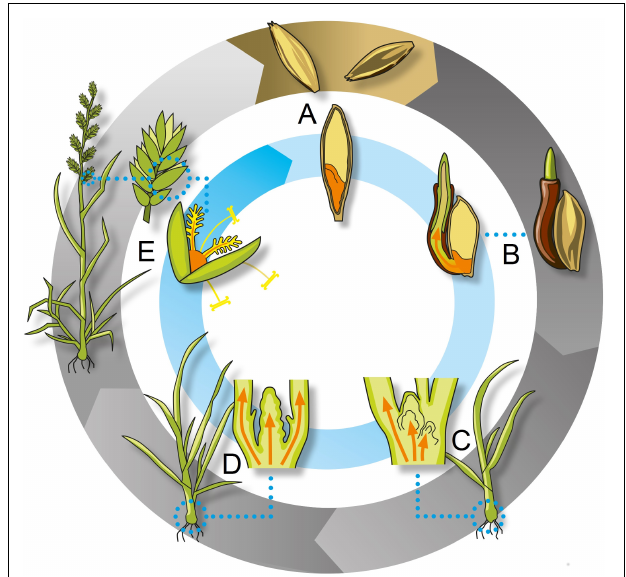
FIGURE 1 | Vertical transmission of Epichloë festucae var. lolii hyphae. The outer ring represents the grass reproductive cycle (both vegetative and sexual), and the inner ring the fungal vertical transmission cycle (asexual only). Within mature seeds (A) , hyphae (orange) are present in the embryo, as well as a number of other seed structures such as the scutellum, and a region between the embryo and the endosperm called the “infection layer” (Philipson and Christey, 1986; Card et al., 2011). Upon germination (B) , hyphae within the embryo colonize the seedling, including the shoot apical meristem, and developing shoot organ primordia using hyphal tip growth that allows the branching of hyphae required to colonize and ramify through meristem and organ primordia. By contrast, hyphal extension in growing leaves occurs primarily through intercalary compartment growth until the leaf matures (Christensen et al., 2008). Each leaf subtends an axillary bud which is colonized prior to tiller outgrowth, thus enabling the hyphae to colonize the shoot apex of the newly formed daughter tillers (C) and from there, all nascent aerial plant structures. The resulting grass plants are comprised of a hierarchy of tillers and it is not uncommon for all tillers of an infected grass plant to contain hyphae. However, organ primordia that have escaped hyphal colonization are generally observed to develop endophyte free (Wilson and Easton, 1997; Christensen et al., 2000). Under environmental cues (temperature, light duration), each vegetative shoot apex has the potential to differentiate into a reproductive inflorescence primordium (D) . Hyphae colonize the developing reproductive tissues, and can be identified among the cells of most floral tissues, including the ovaries (E) . Upon fertilization, hyphae in the ovary penetrate the embryo and are incorporated into other seed structures (Sampson, 1933; Liu et al., 2017; Zhang et al., 2017). It is noted that hyphae have not been observed in grass pollen (Liu et al., 2017) and thus the transmission of endophytes into seed through the asexual cycle is generally deemed to be exclusively maternal. Moreover, there are examples where epibiotic conidia have been shown to be capable of horizontal spread (Tadych et al., 2012, 2014). However, the extent to which this may occur is unclear, and has not been documented in AR37 associations with L. perenne